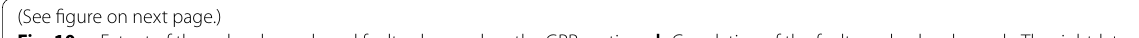
figure on next Fig. 10 a Extent of the paleochannels and faults observed on the GPR sections. b Correlation of the faults and paleochannels. The right-lateral offset of the paleochannel A is associated with the F1. The Ikeda fault trace and two offset terrace risers are from Tsutsumi and Goto (2006). Inset shows subsidiary structures associated with a strike-slip fault (modified after Sylvester 1988). PDZ: principal displacement zone, R: synthetic shears, R’: antithetic shear, P: secondary synthetic shear, TF: thrust fault, NF: normal